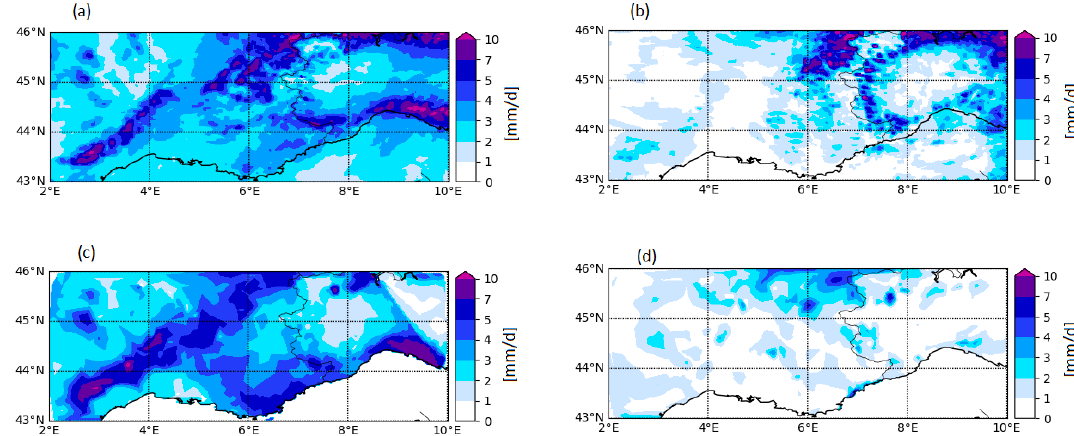
Figure 4. Aggregated mean daily precipitation divided into strong (a, c) and weak (b, d) forcing conditions. Displayed are ensemble mean (a, b) and interpolated rain-gauge observations (c, d) of 24h precipitation for the 2-month period in autumn 2012.